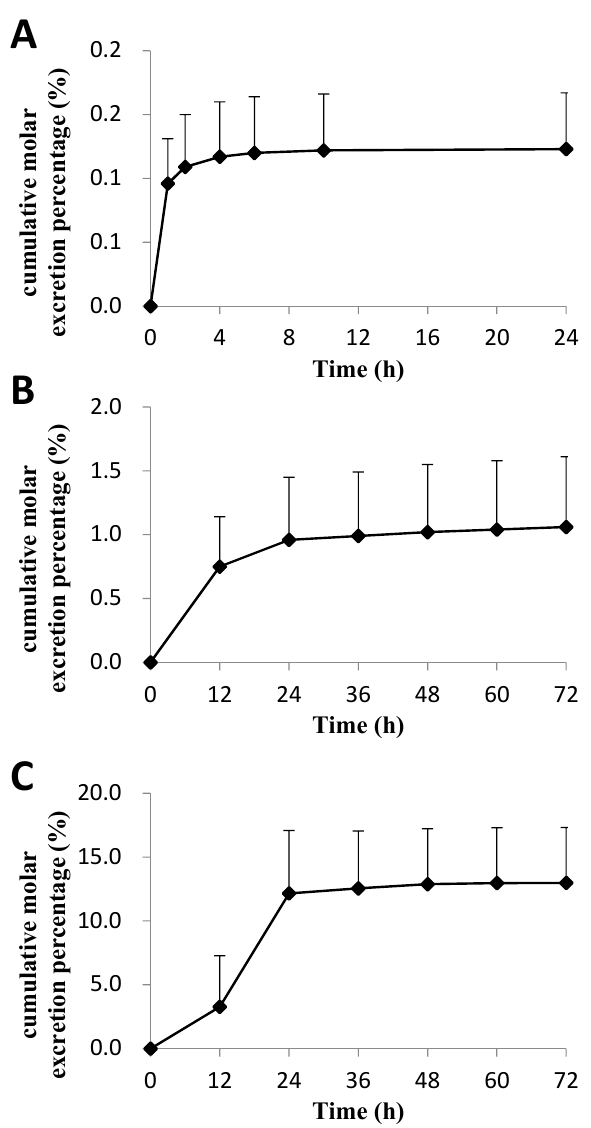
Figure 4. The cumulative molar excretion percentages of C118P and C118 in bile ( A , n = 10), urine ( B , n = 6) and feces ( C , n = 6) of rats after i.v. administration of C118P at 20 mg/kg. Data are presented as the arithmetic mean ± SD.